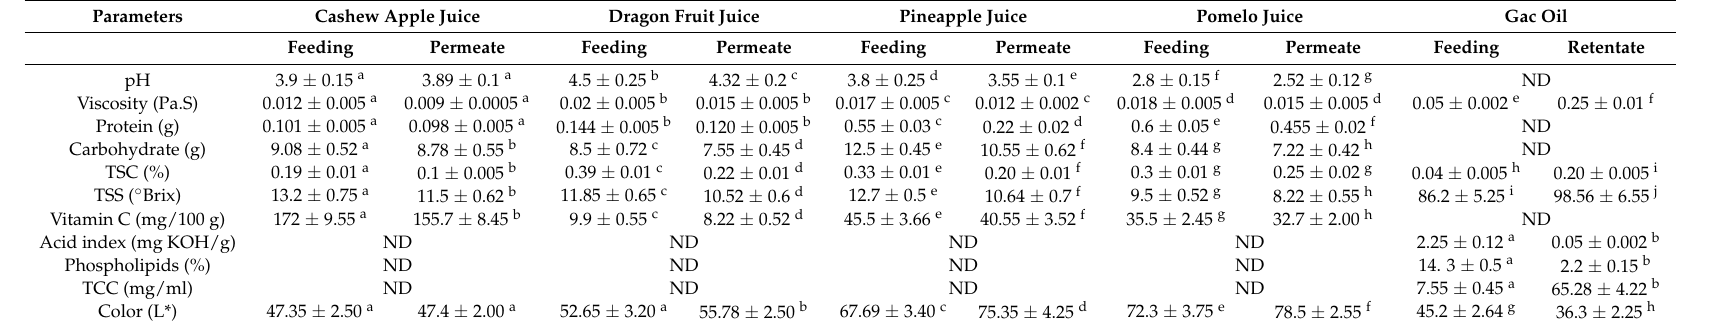
Table 9. Physiochemical measurement of feeding vs permeate (fruit juice) and retentate (of gac oil). Parameters Cashew Apple Juice Dragon Fruit Juice Pineapple Juice Pomelo Juice Gac Oil Feeding Permeate Feeding Permeate Feeding Permeate Feeding Permeate Feeding